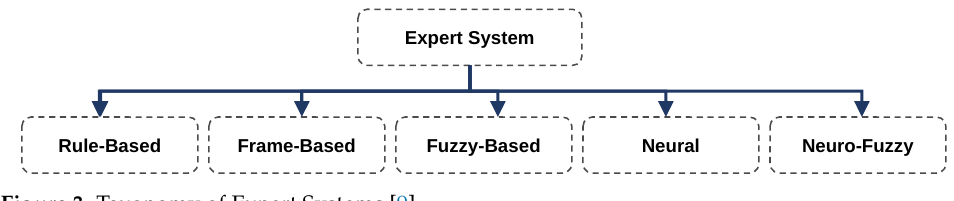
Figure 3. Taxonomy of Expert Systems [9].